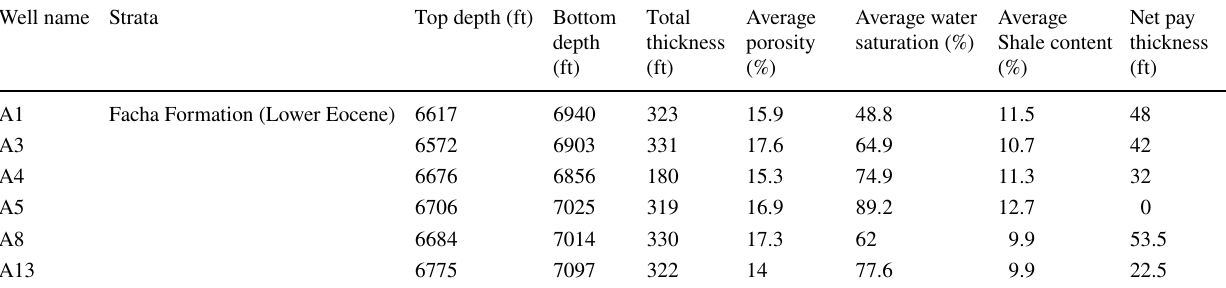
Table 1 Reservoir parameters of the Facha reservoir Well name